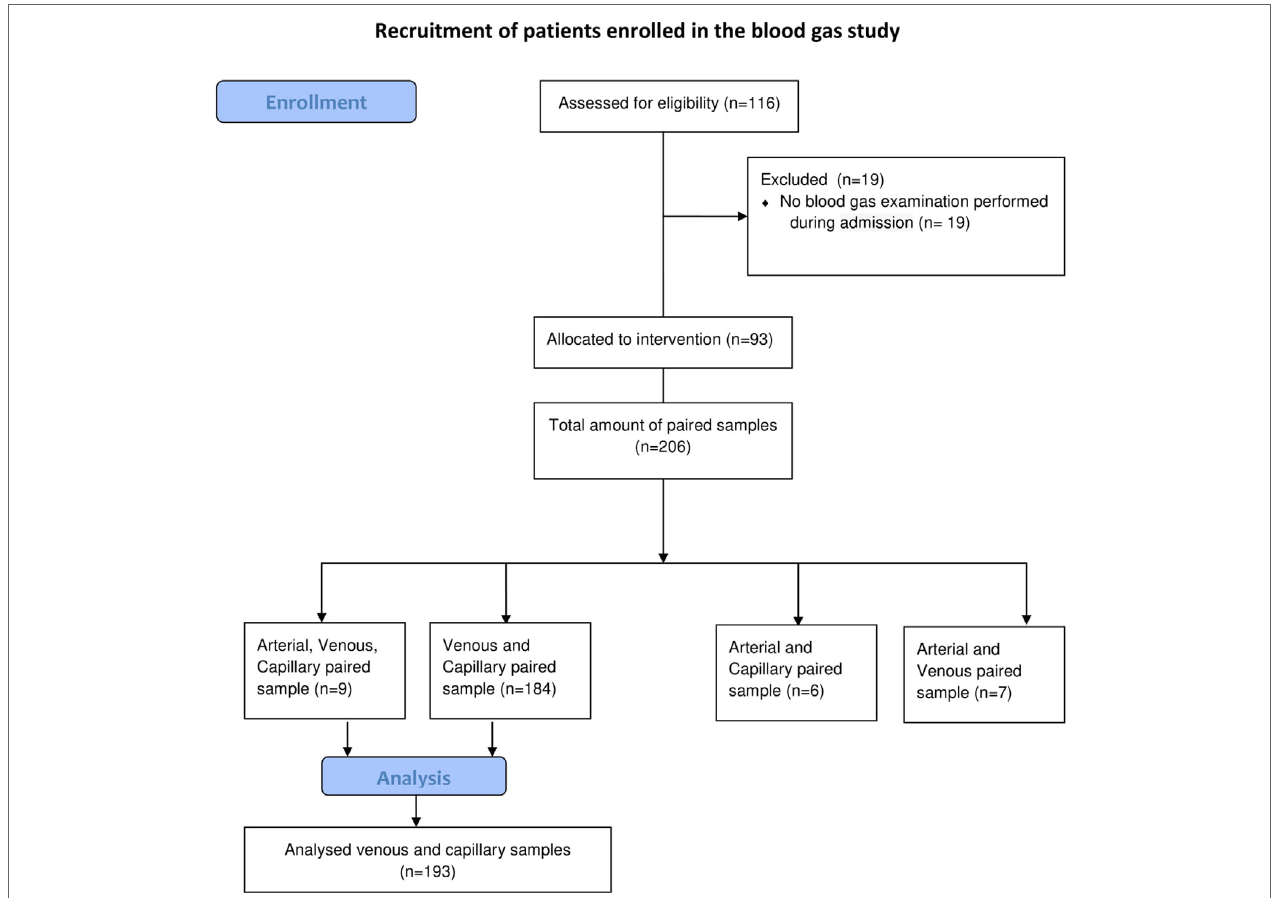
FigUre 1 | Recruitment of patients enrolled in the blood gas